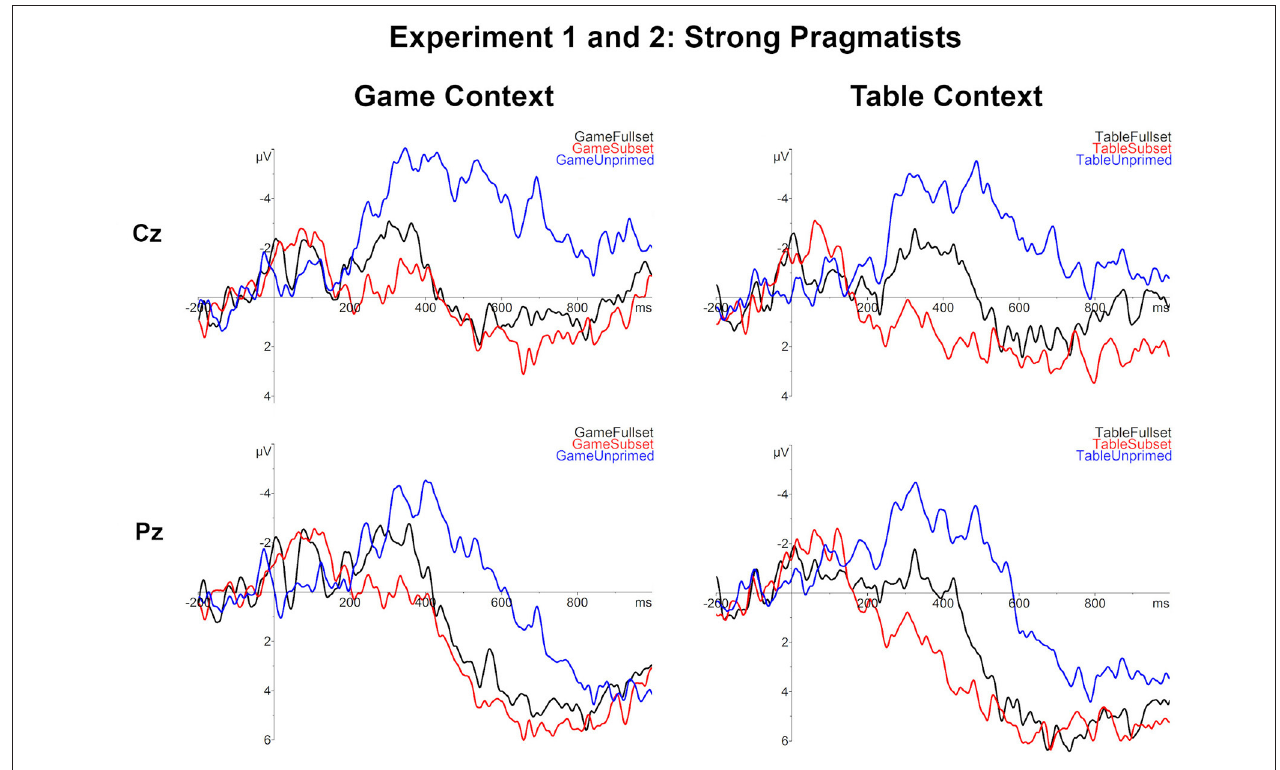
FIGURE 7 | The comparison of subject averages in all conditions for the strong pragmatists, including the subject who displayed a mixed weak/strong response pragmatic response pattern ( N =